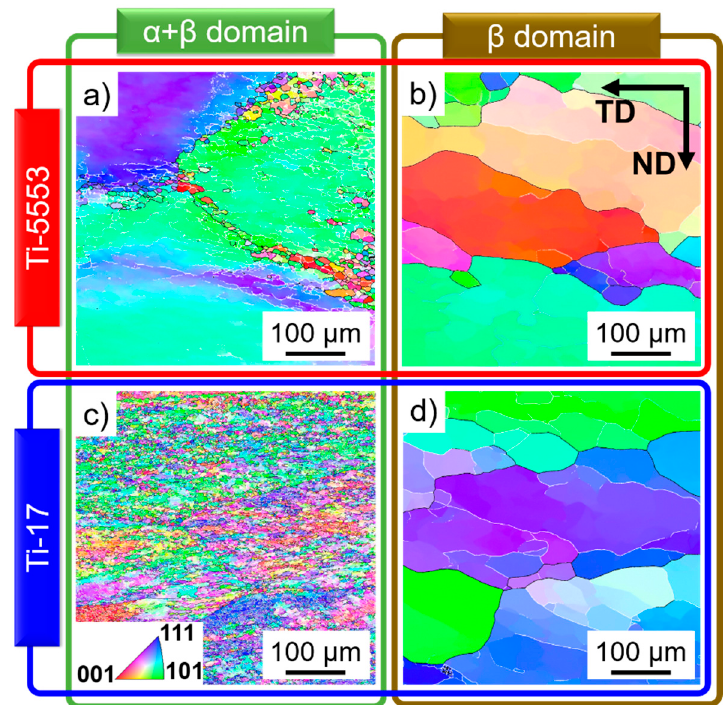
Figure 3. Microstructures of the ( a , b ) Ti-5553 and ( c , d ) Ti-17 after deformation at 0.001 s − 1 and ( a ) 820 ◦ C, ( b ) 920 ◦ C, ( c ) 810 ◦ C, ( d ) 970 ◦ C. Only the β -phase is indexed in the EBSD inverse pole figure maps, and the black lines are HAGBs.